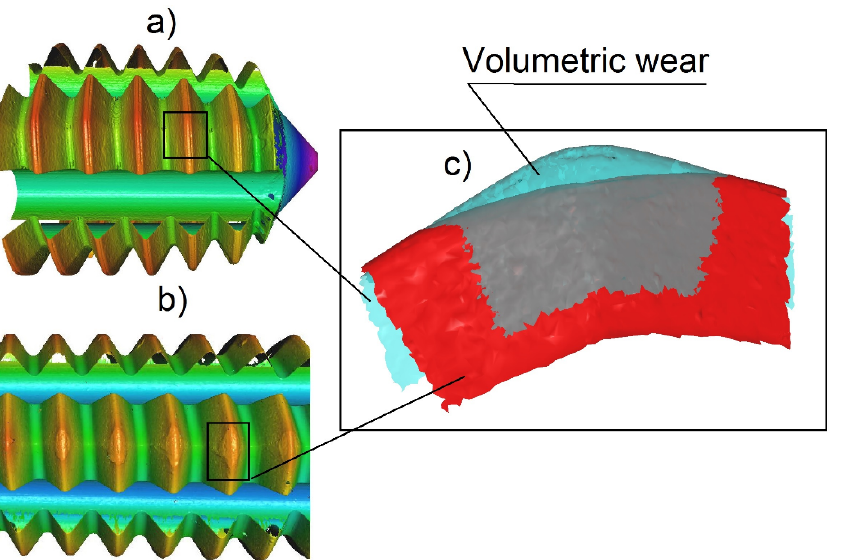
Figure 15. A modern method of wear analysis—measurement of the volumetric wear; ( a ) new tool, ( b ) worn tool, ( c ) a digital subtraction of the surfaces – the worn away material.